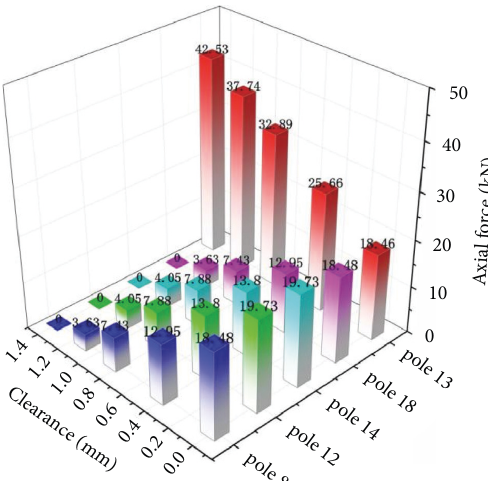
Figure 9: The change of the maximum axial force in the falsework when there are gaps between the 4 poles and their main